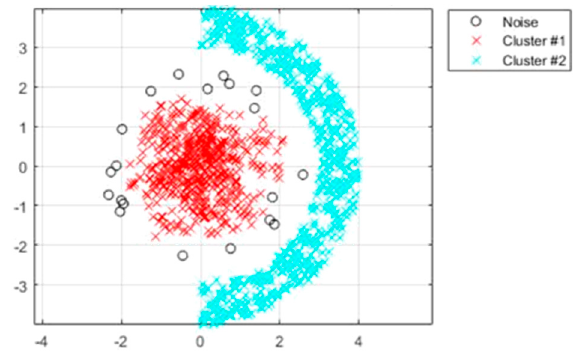
Figure 2. Results of DBSCAN clustering.